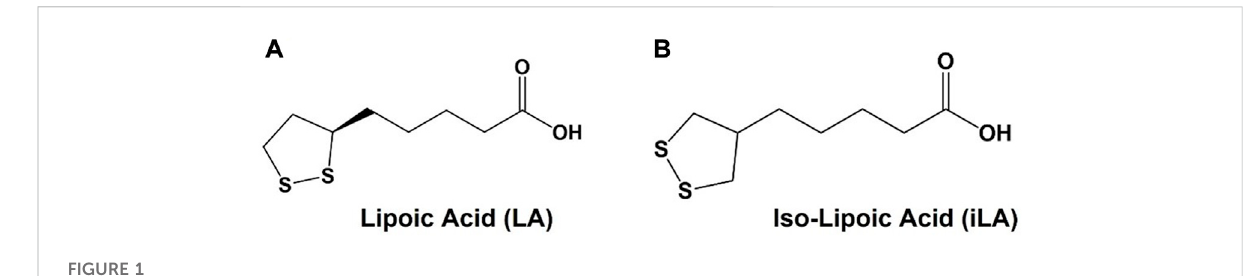
FIGURE 1 (A) Structures of lipoic (LA) and (B) iso-lipoic acid